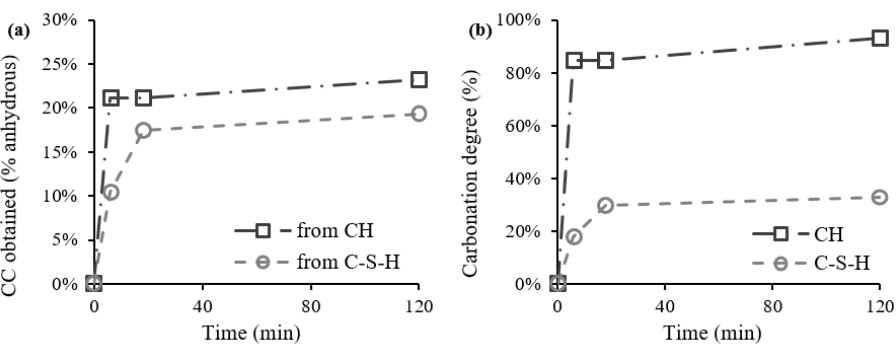
Figure 9. CC obtained from CH and C-S-H ( a ) and carbonation degree ( b